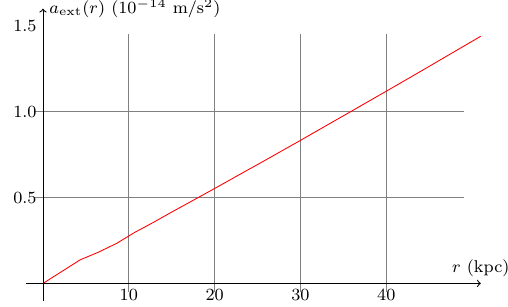
Fig. 1 Radial acceleration in a spherically symmetric configuration due to the FLRW cosmological background in the MOG theory. Devia- tions from Birkhoff’s theorem in the theory result in a barely observable perturbation due to matter outside of radius r . Nominal values of the parameters in Eqs. (5) and (8) were